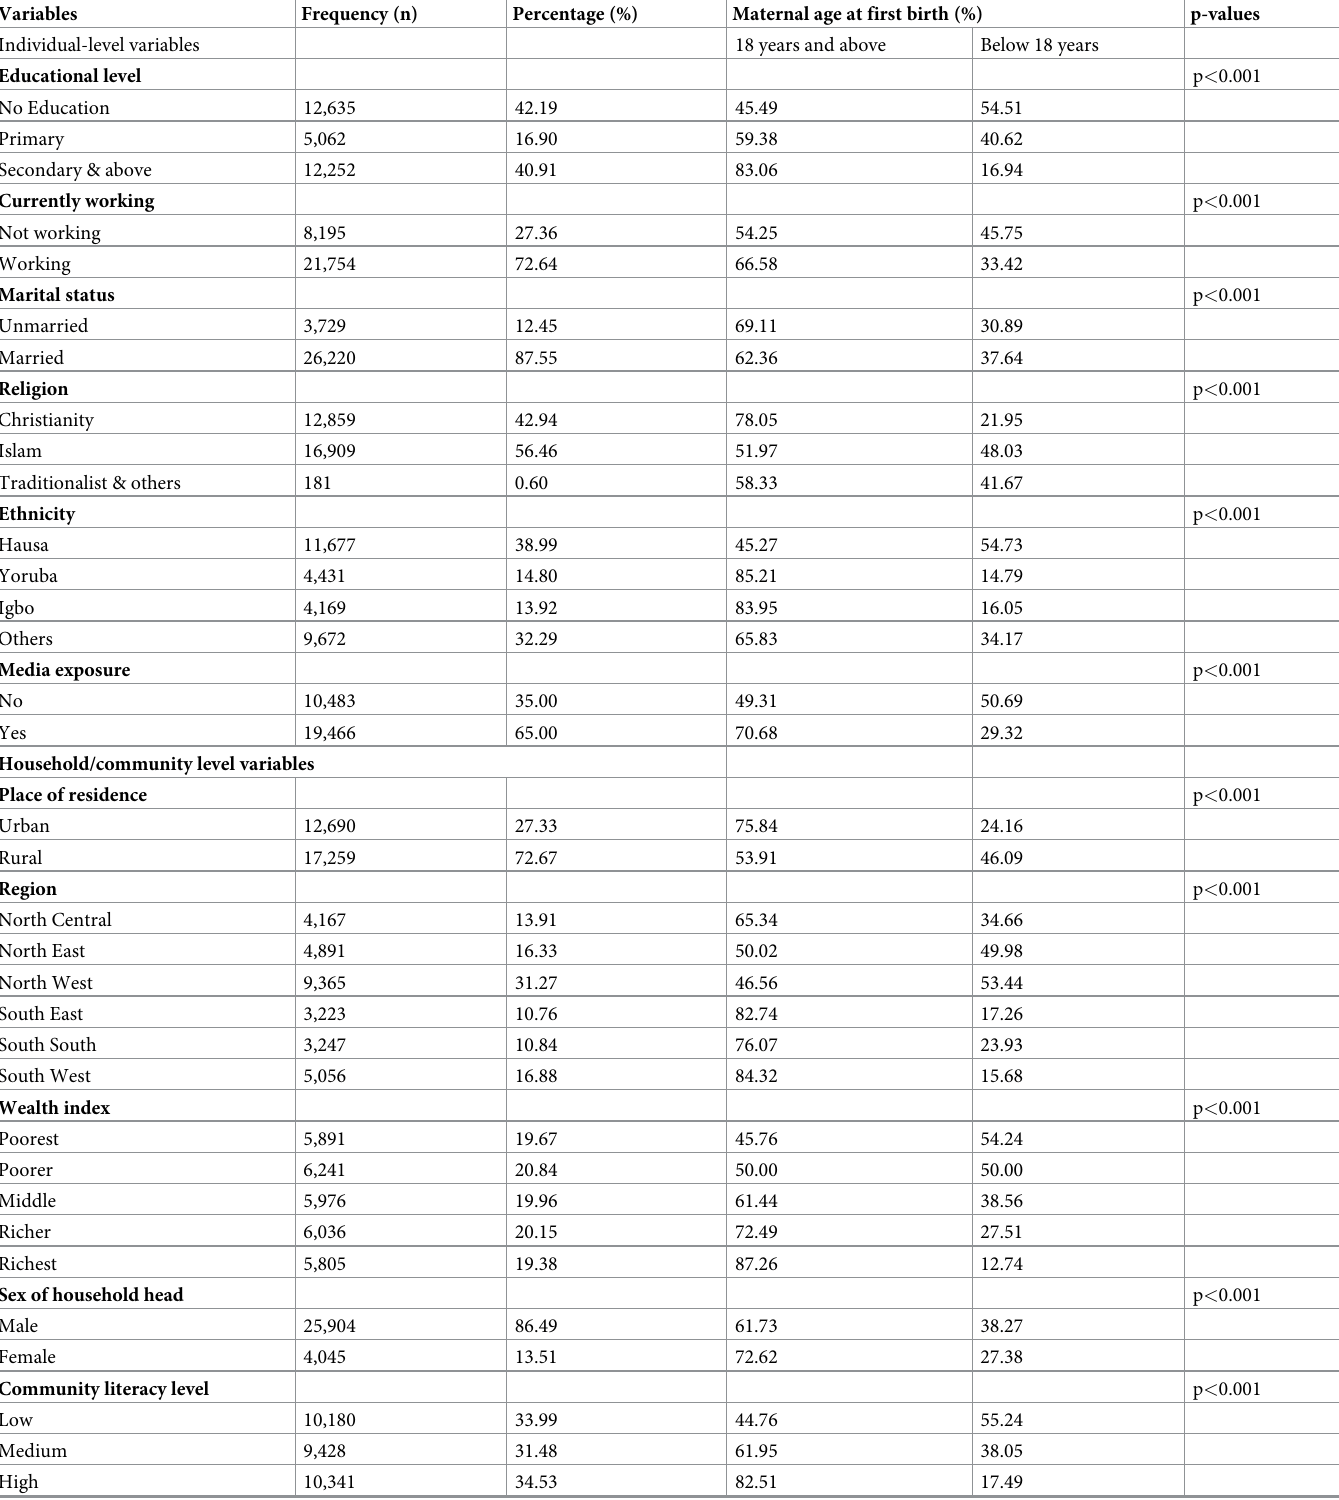
Table 1. Distribution of maternal age at first birth by explanatory